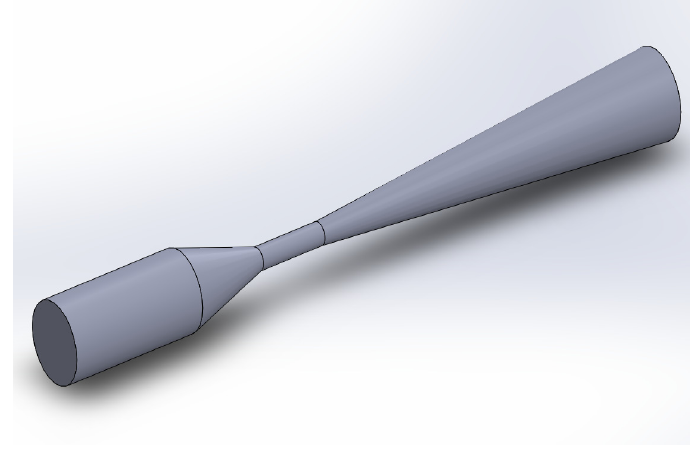
Figure 3. The 2 ‐ D sketch of Venturi ‐ type baseline microbubble Generator model.